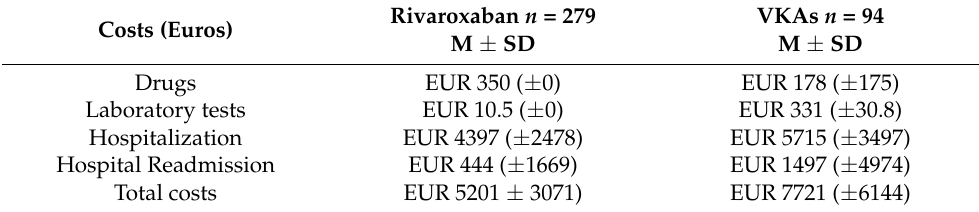
Table 3. Rivaroxaban versus VKAs average costs per patient for the unadjusted population. Costs (Euros)